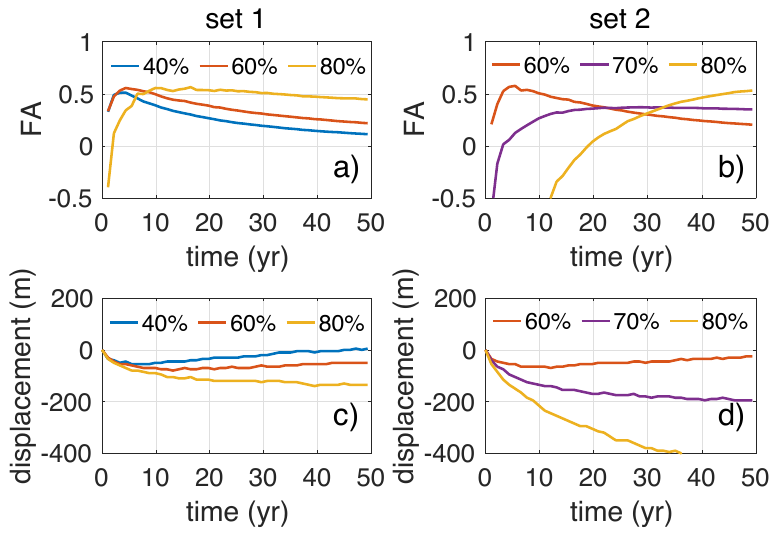
Figure 6. Sensitivity of the long-term mega-nourishment evolution to the percentage of high-angle waves in a bimodal wave climate (Set 1 ( a , c )) and in a unimodal wave climate (Set 2 ( b , d )). Time evolution